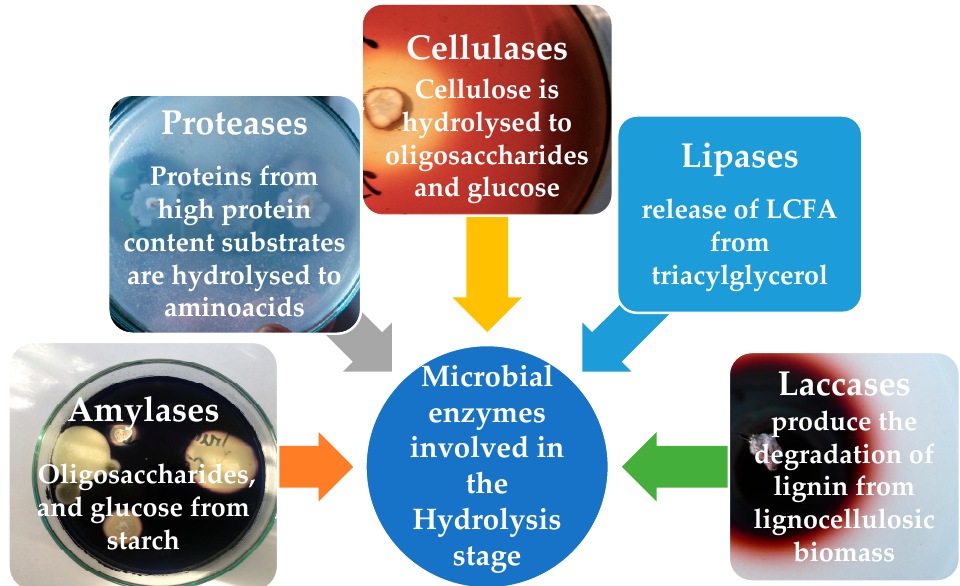
Figure 3. Amylases, proteases, cellulases, lipases, and laccases are produced by microorganisms in the hydrolysis stage of AcoD.